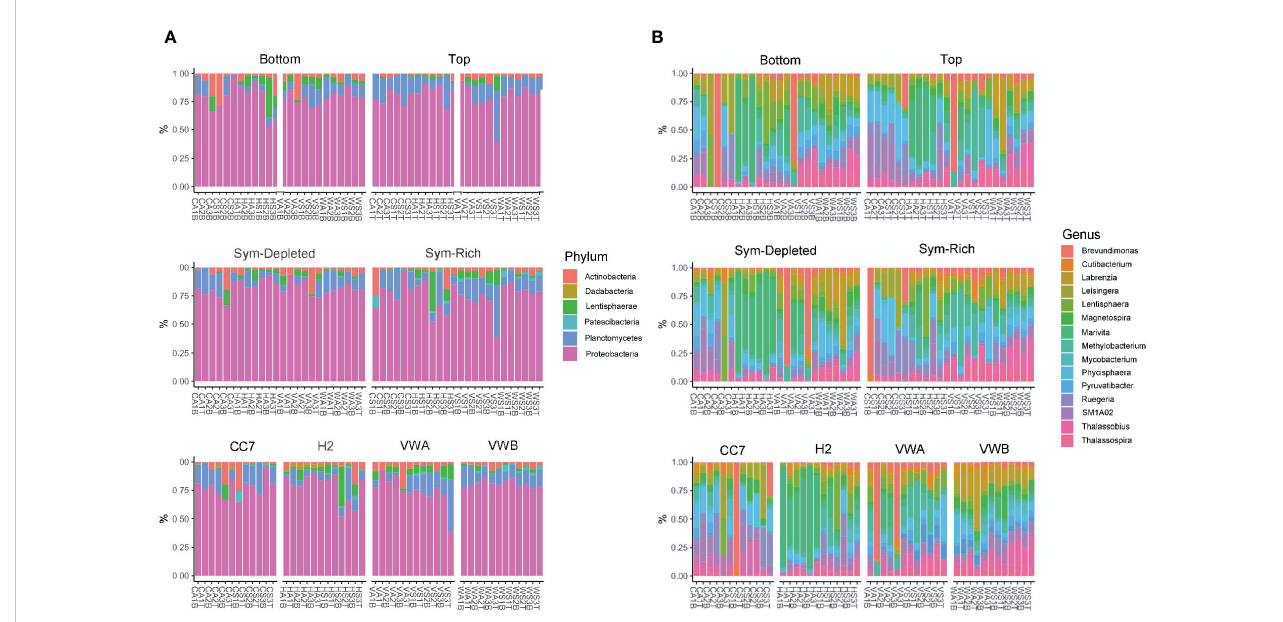
FIGURE 4 Bacterial community composition at the level of phylum (A) and genus (B) . Each color represents a genus or phylum with a relative abundance >1% across all